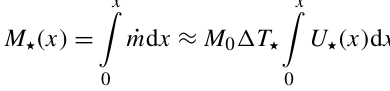
Figure A3. Evolution of m (a) , U (b) and T (c) along Z for the tide- water glaciers with high discharge ( q sg = 0 . 1m 2 s − 1 , black line), low discharge ( q sg = 10 − 5 m 2 s − 1 , red line) and a floating tongue glacier ( q sg = 0 . 1m 2 s − 1 , green line). Solid lines indicate plumes with E 0 = 0 . 1 while dotted lines represent plume with E 0 = 0 . 036. The corresponding “balance” approximations m (cid:63) = M 0 U (cid:63) (cid:49)T (cid:63) , U (cid:63) and T (cid:63) are overlaid as grey dashed